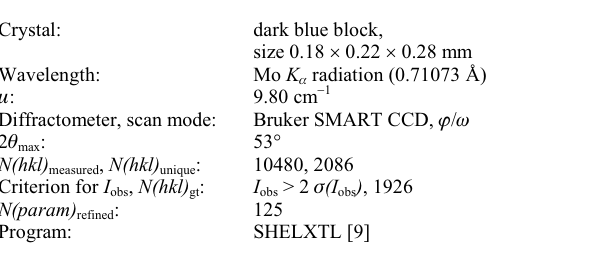
Table 1. Data collection and